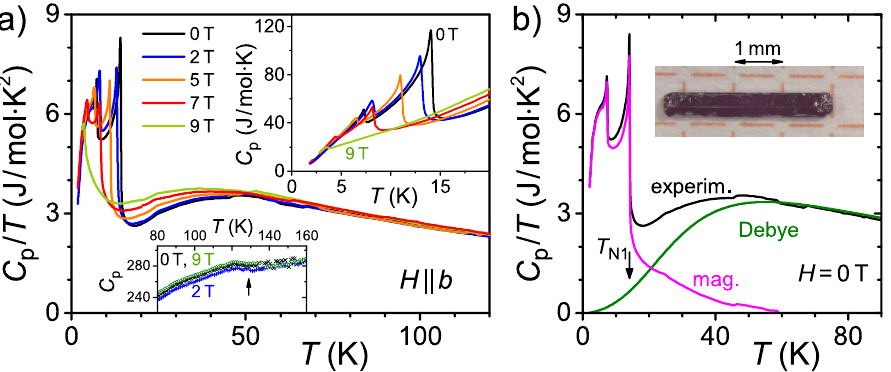
Figure 4. ( a ) Specific heat divided by temperature, C p / T , in dependence on T for applied fields H (cid:31) b up to 9 T. The insets show enlarged views of C p ( T ) within certain temperature ranges (in units of J/mol K). ( b) C ph contribution from a Debye model (green curve) fitted to the experimental C p ( T ) -data (black) within 60 K ≤ T ≤ 200 K and used to estimate C mag / T (magenta). Inset: photograph of one representative Eu 5 In 2 Sb 6 sample with the long dimension corresponding to the c